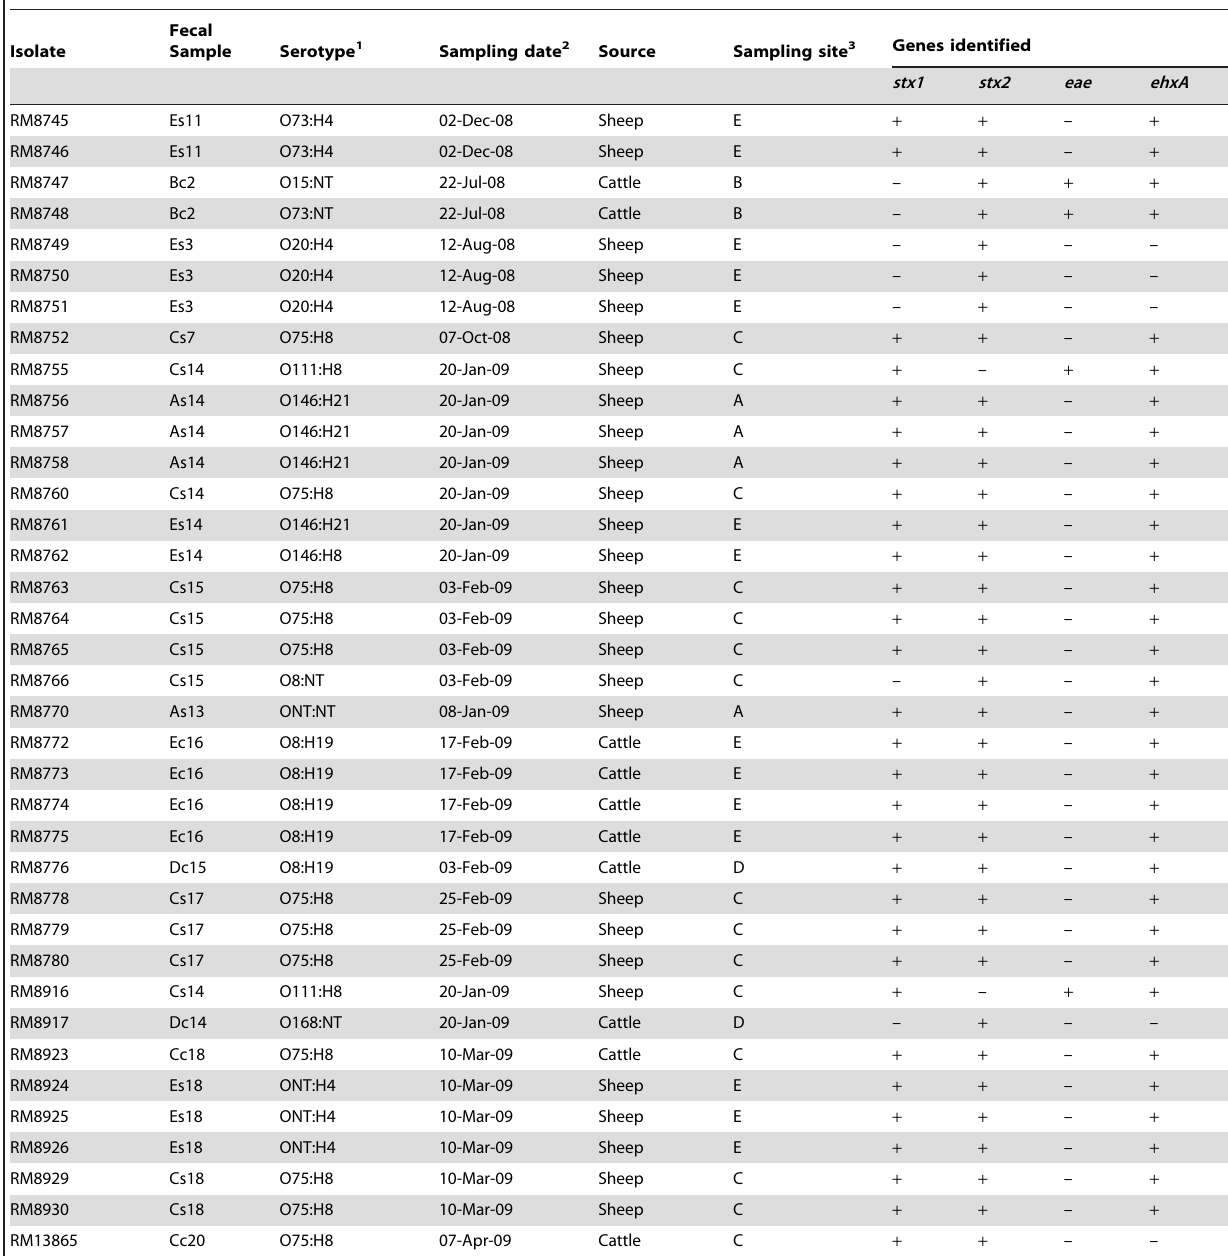
Table 3. List of E. coli non-O157 isolates used in this study.